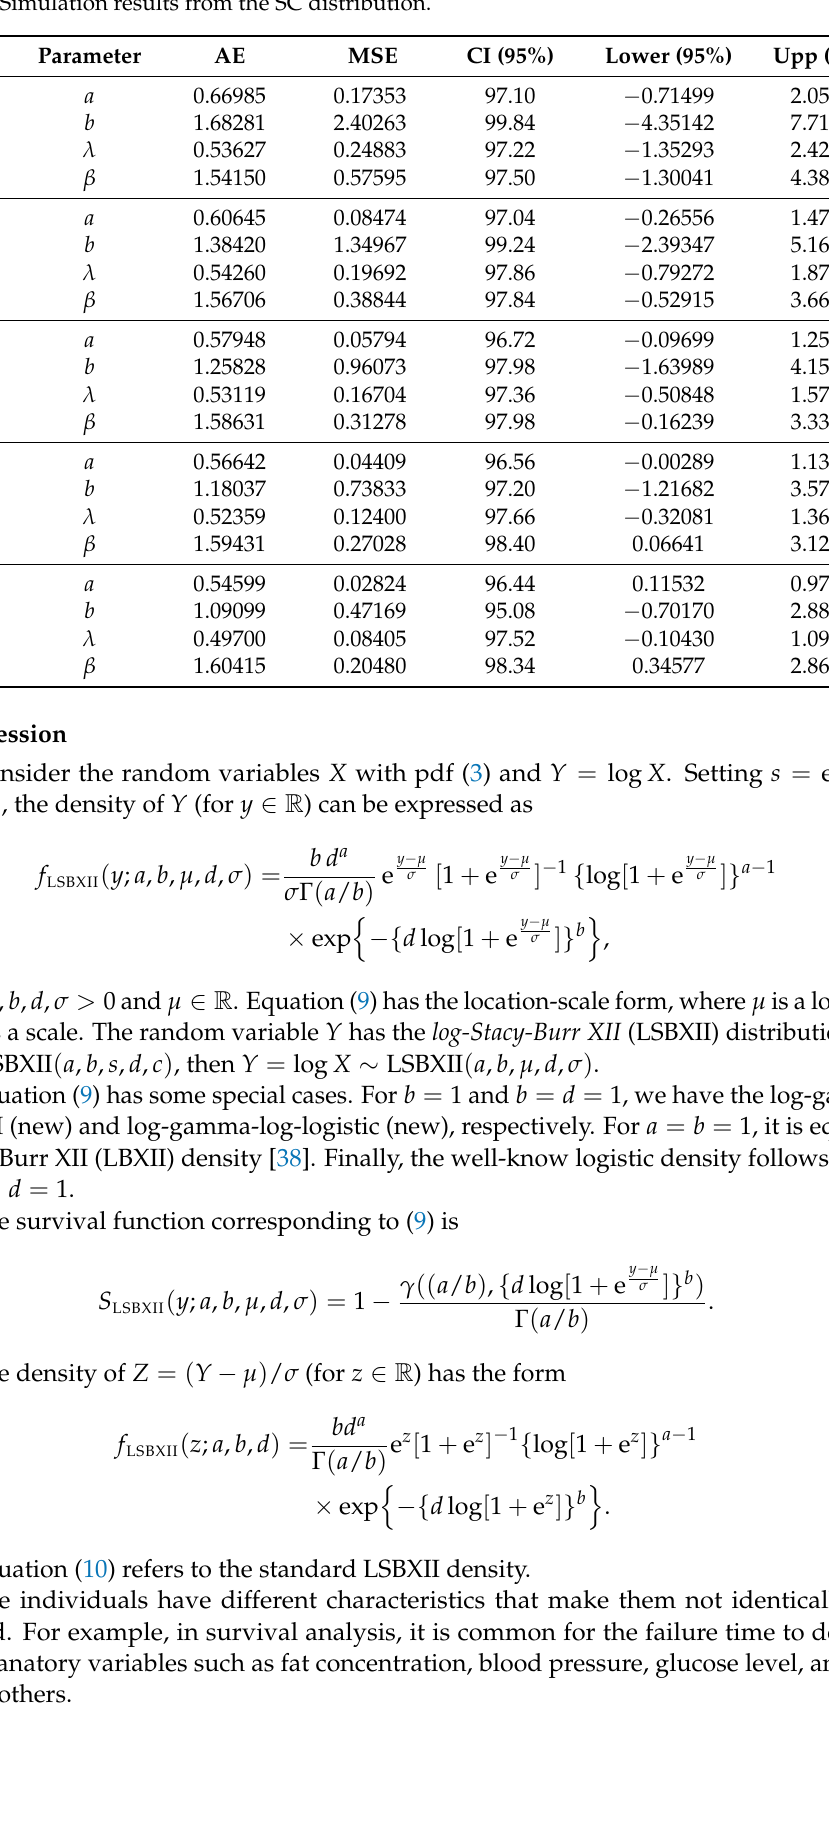
Table 2. Simulation results from the SC